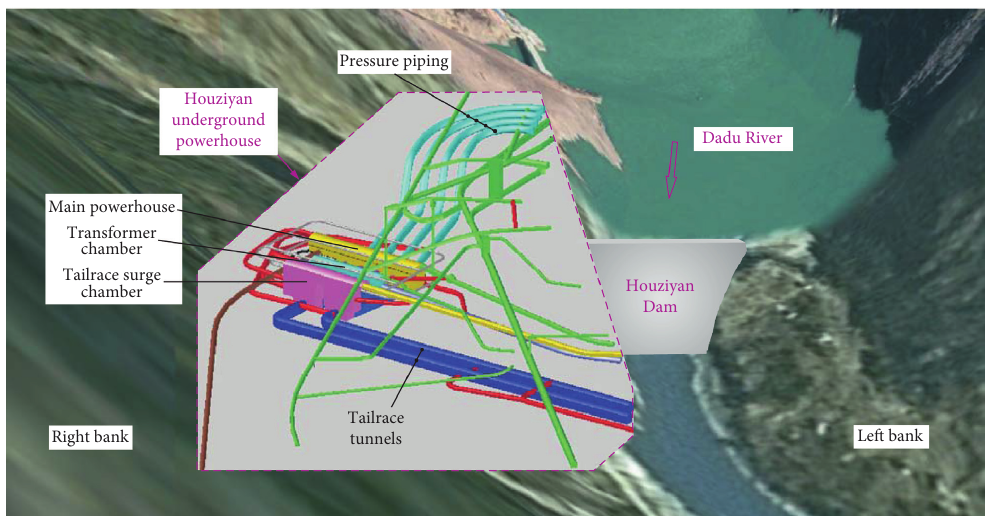
Figure 2: The Houziyan underground powerhouse inside the mountain on the right bank of the Dadu River. Table 2: Statistics of deformation and failure of the surrounding rock mass in some large-scale underground powerhouses during construction